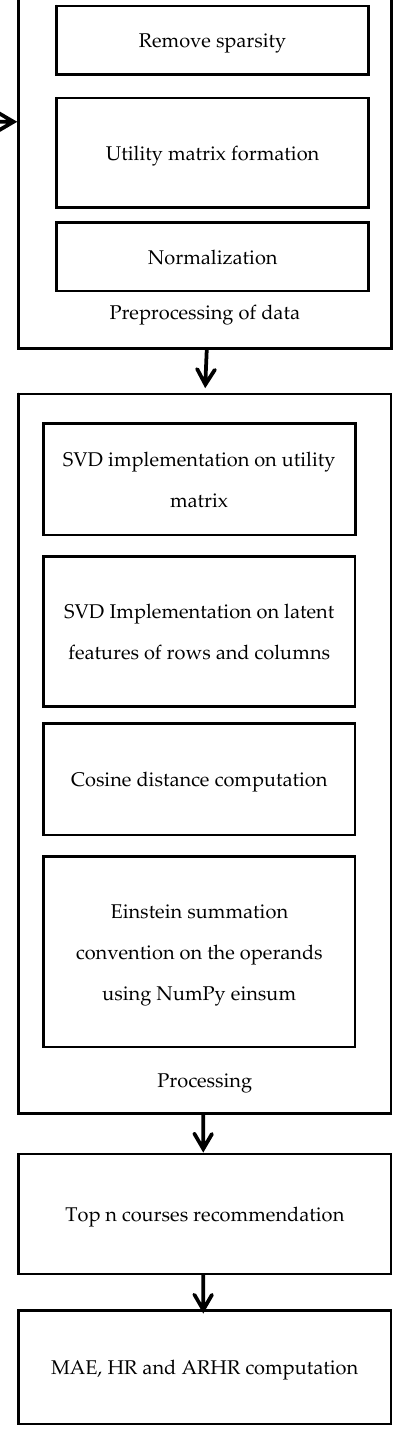
Figure 3. Workflow diagram of SVD.